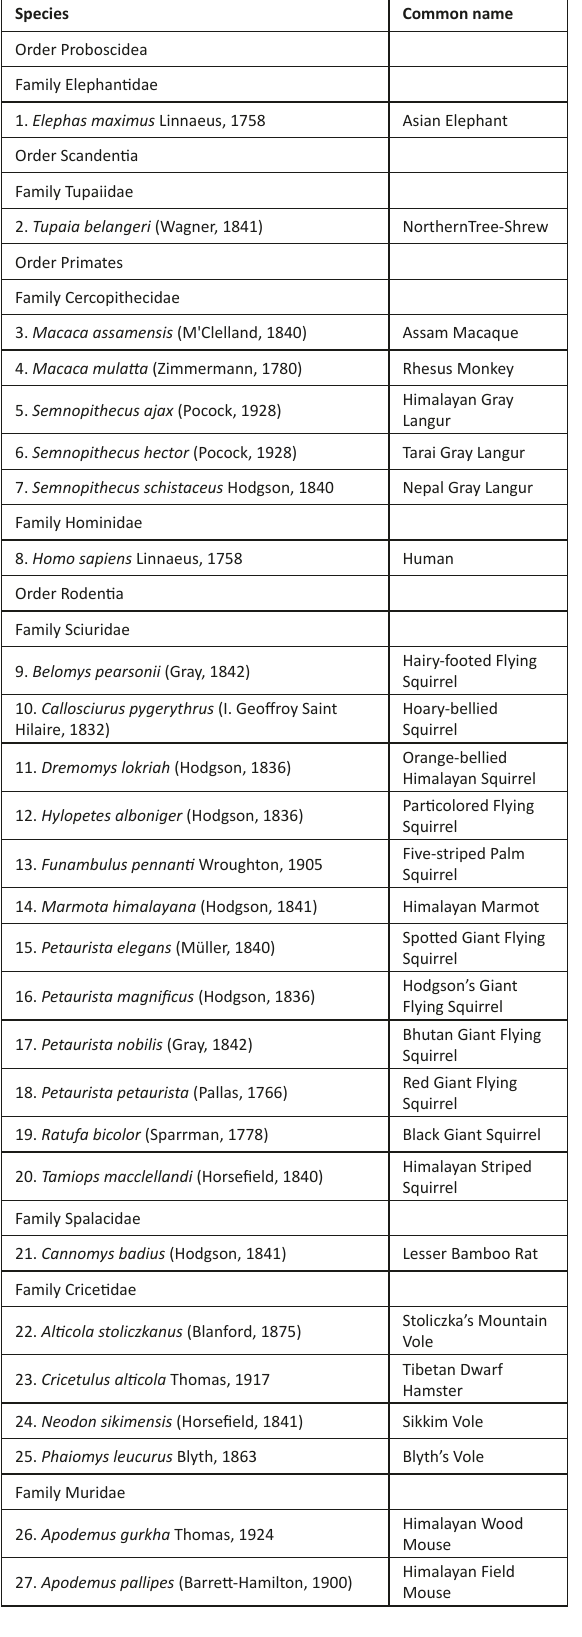
Table 1. Checklist of mammals of Nepal